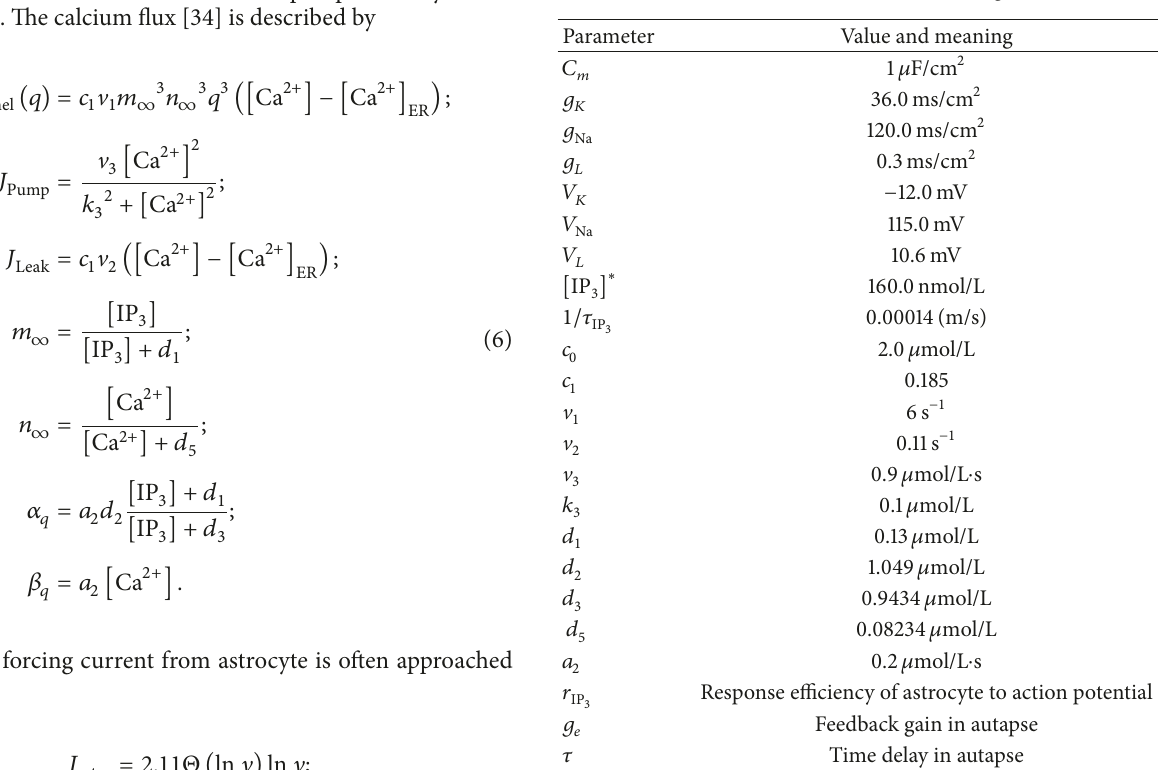
Table 1: Parameter values